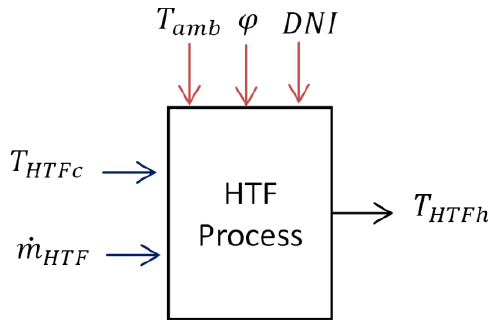
Figure 7. Heat transfer fluid (HTF) ‐ heating process model.